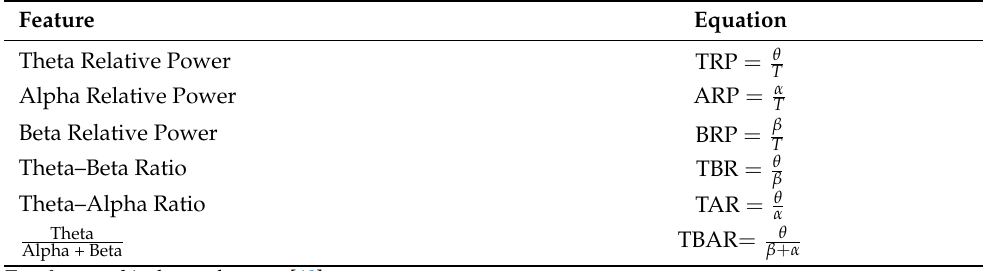
Table 1. Feature equations for attention detection.